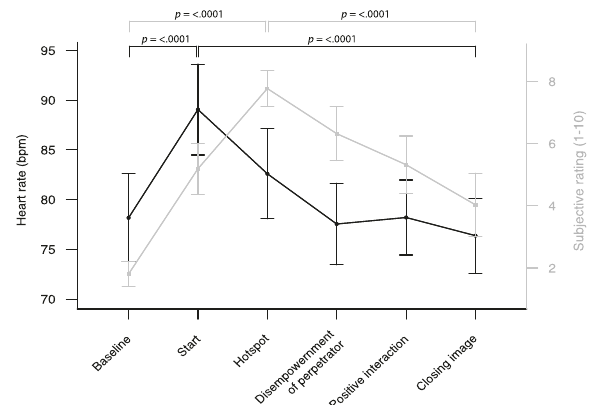
Fig. 2 Heart rate and self-reported arousal values during imagery rescripting. Mean HR (bpm), respective standard errors (lines and scale in black) and self-reported arousal ratings (lines and scale in grey) at different time points during the imagery rescripting session (i.e., baseline, start, hotspot, disempowerment of perpetrator, positive interaction and closing